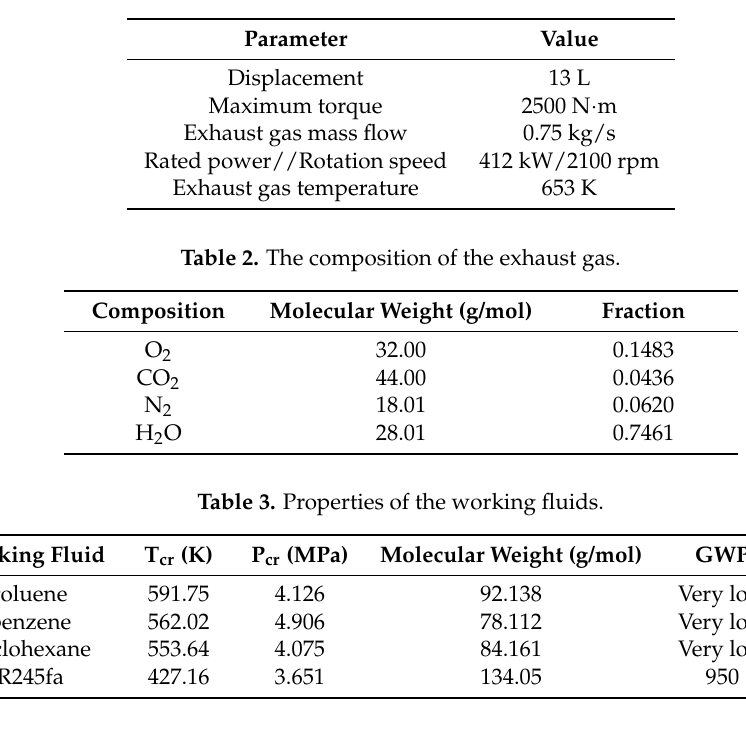
Table 1. Main technical parameters of the diesel engine.